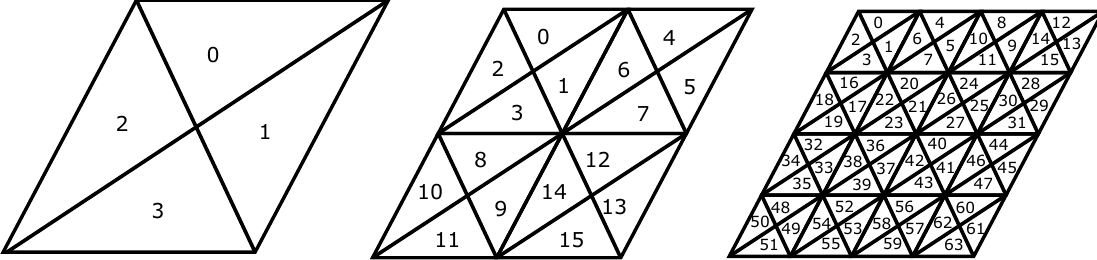
Figure 10. An example of the indexing scheme at resolutions 1, 2 and 3 from left to right. Note that this is duplicated for every rhombus in RT. These Z shaped patterns within small rhombuses are repeated along rows and columns of small rhombuses in row major order. We index small rhombuses row by row, most evident in resolution level 3 on the